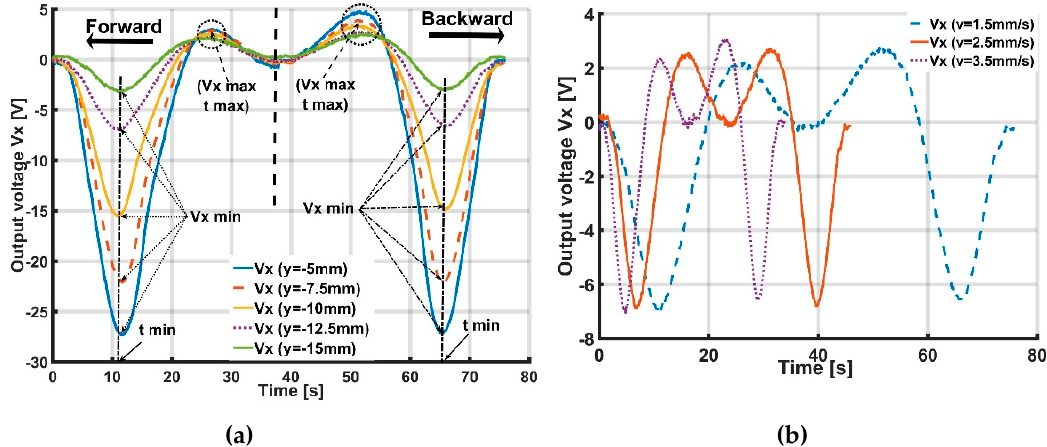
Figure 15. Output voltage V x of accelerometer with X-sliding case 1 when distance y increases from 5 to 15 mm. Value of V x min , V x max only depends on distance y and t min , t max depends on magnitude of velocity v . Based on accelerometer’s output voltage, distance y from accelerometer to sliding line and magnitude of velocity v can be estimated. ( a ) Output voltage V x with di ff erent distances y ( mm ) . ( b ) Output voltage V x with di ff erent magnitudes of velocity v ( mm/s ) .